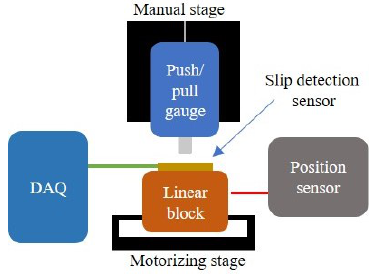
Figure 5. Testbed for slip